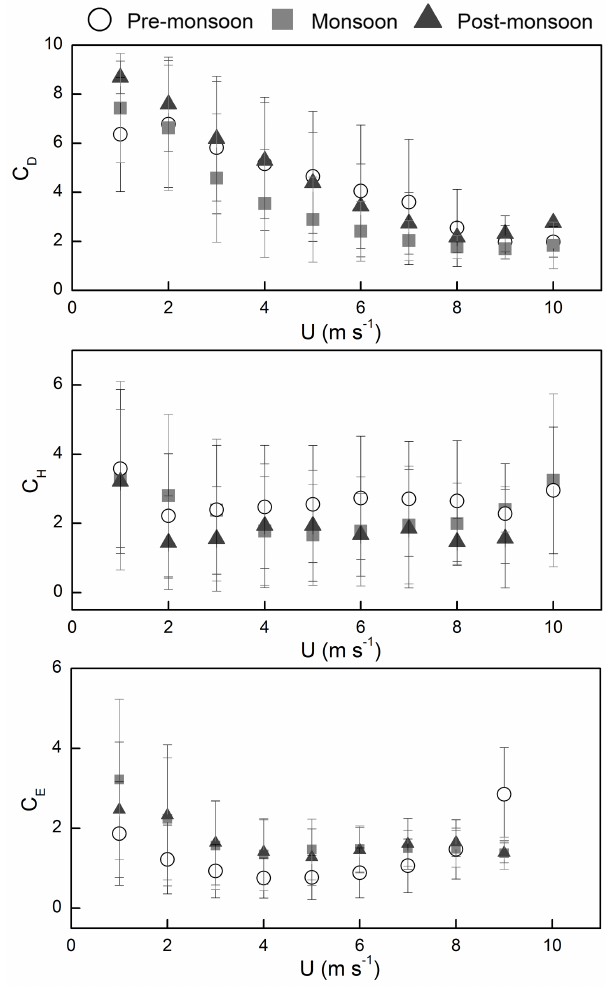
Figure 7. The relationship between bin (bin width 1ms − 1 ) av- eraged drag coefficient (the momentum bulk transfer coefficient, C D ), Dalton number (the heat bulk transfer coefficient, C H ), Stan- ton number (the moisture bulk transfer coefficient, C E ) and wind speed ( U ) during pre-monsoon, monsoon and post-monsoon peri- ods for the whole study period. The error bars show the ± 1 standard deviation of the average